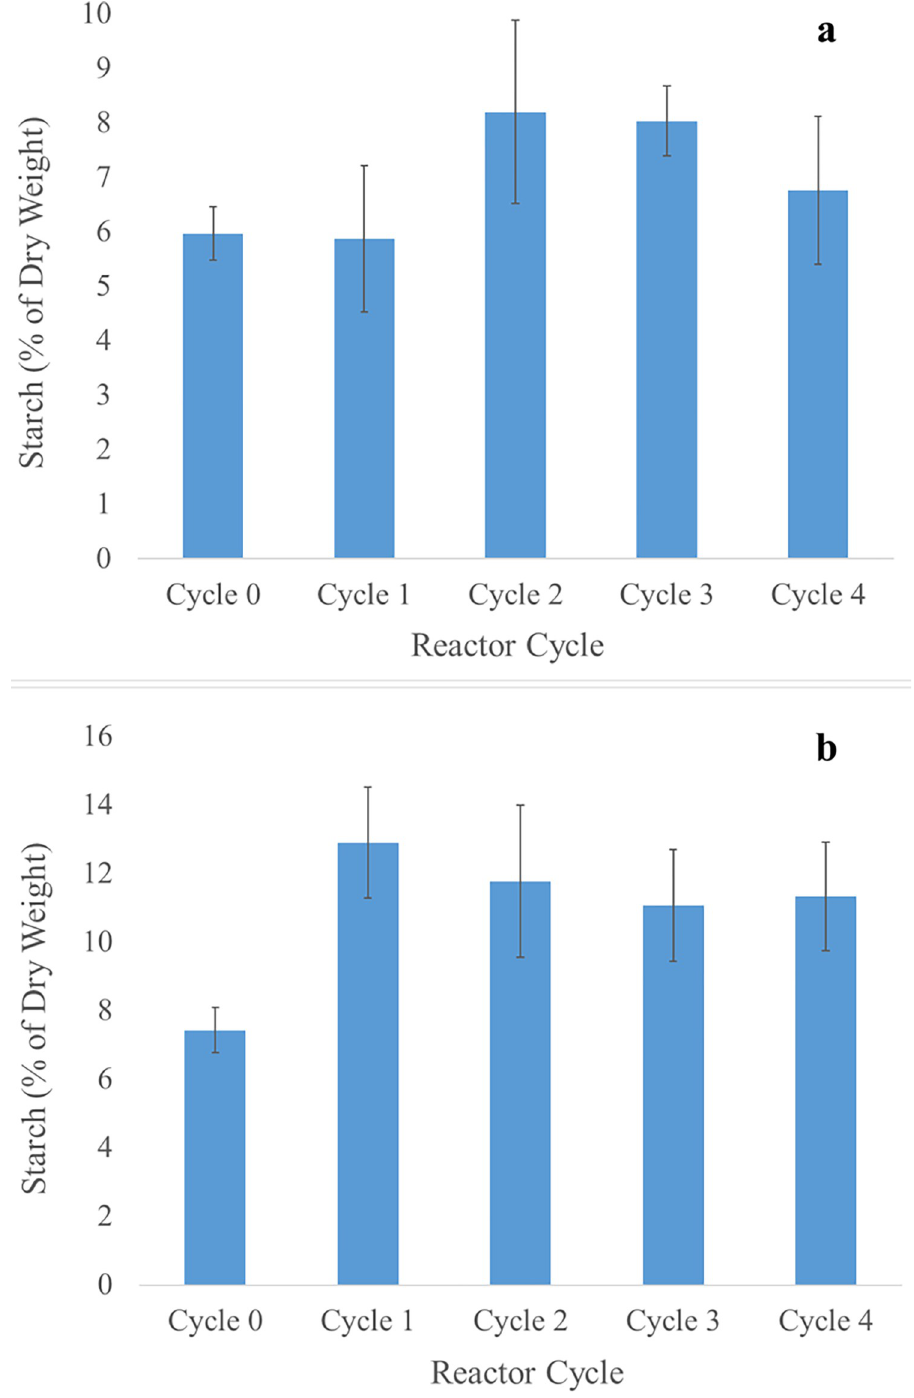
Fig 2. Carbohydrate storage in algal biomass. Starch content of a) pH 9 and b) pH 7.5 reactors over the course of feast-famine cycles. Error bars represent one standard deviation above and below of three biological triplicates.